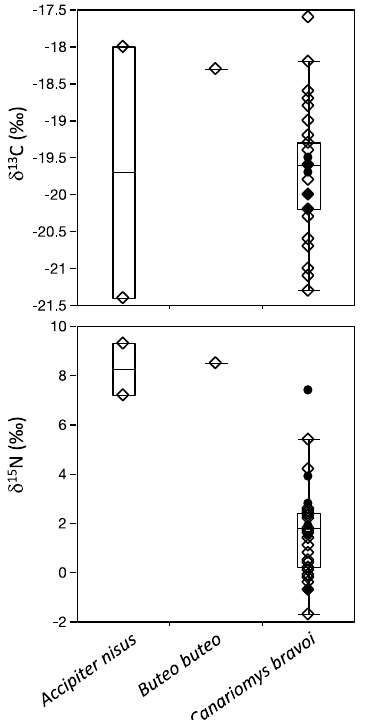
Figure 2. Boxplots comparing δ 13 C and δ 15 N values for taxa at Icod. Boxes represent 25 and 75 ‰ quartiles, and whiskers contain 1.5 times the interquartile range. Diamond symbols indicate the specimens analyzed in this study.